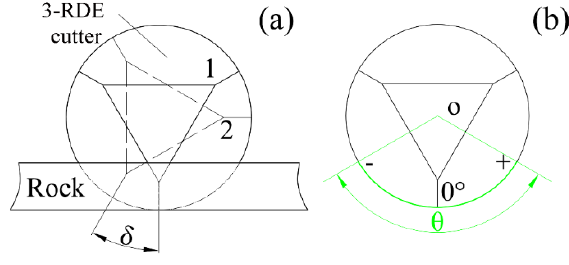
Figure 15. Illustration of ( a ) Rotational angle ( b ) Polar angle.